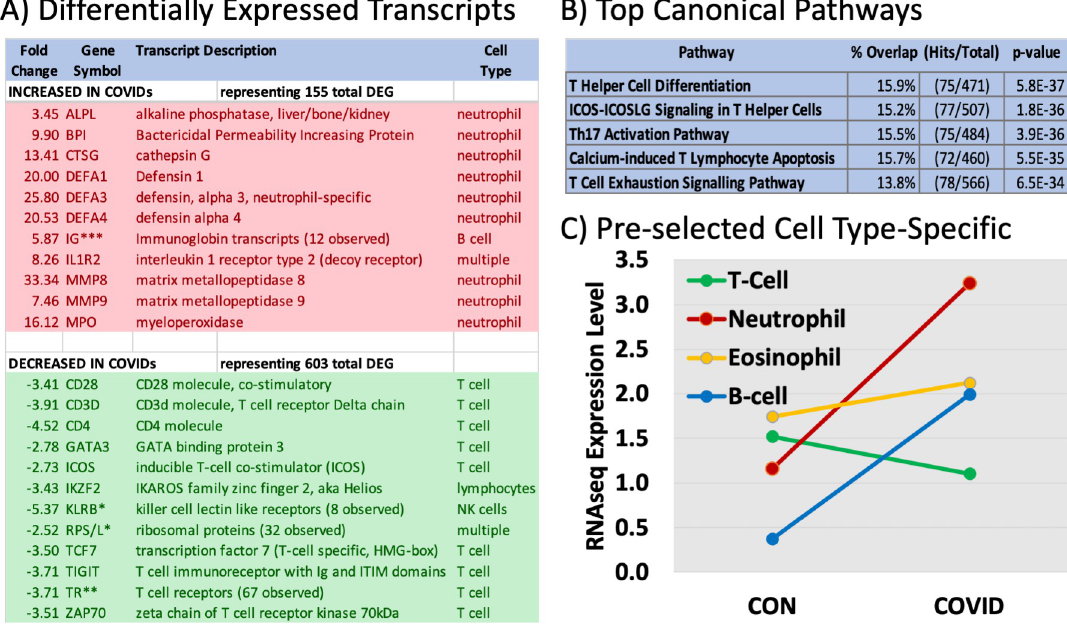
Fig 1. Cell type-specific and differentially expressed genes (DEGs) between COVID-19 and controls. Panel A : The RNAseq data was analyzed to identify differentially expressed genes (DEGs) between controls/incidentals (7) and COVID-19 patients (17) using a triple filtering approach that excluded transcripts with low absolute levels ( < 0.01 RPKM), and then testing for an absolute fold-change of > 2 with a t-test p-value of less than 0.001 uncorrected. A representative subset is shown for increased (red) vs decreased (green) transcripts in COVID-19 patients. Panel B : The total list of 758 DEGs was analysed for the pathways affected using IPA. The 5 top pathways are shown with the % of overlap to the precurated list, the number of transcript matches, and the p-value of the overlap. Panel C : Cell-type-specific RNAs (~10 per cell type) were extracted from the Blood Atlas and then their levels were computed from the RNAseq data of control vs COVID-19 patients. The points reflect the mean expression level of the transcripts in RPKM.